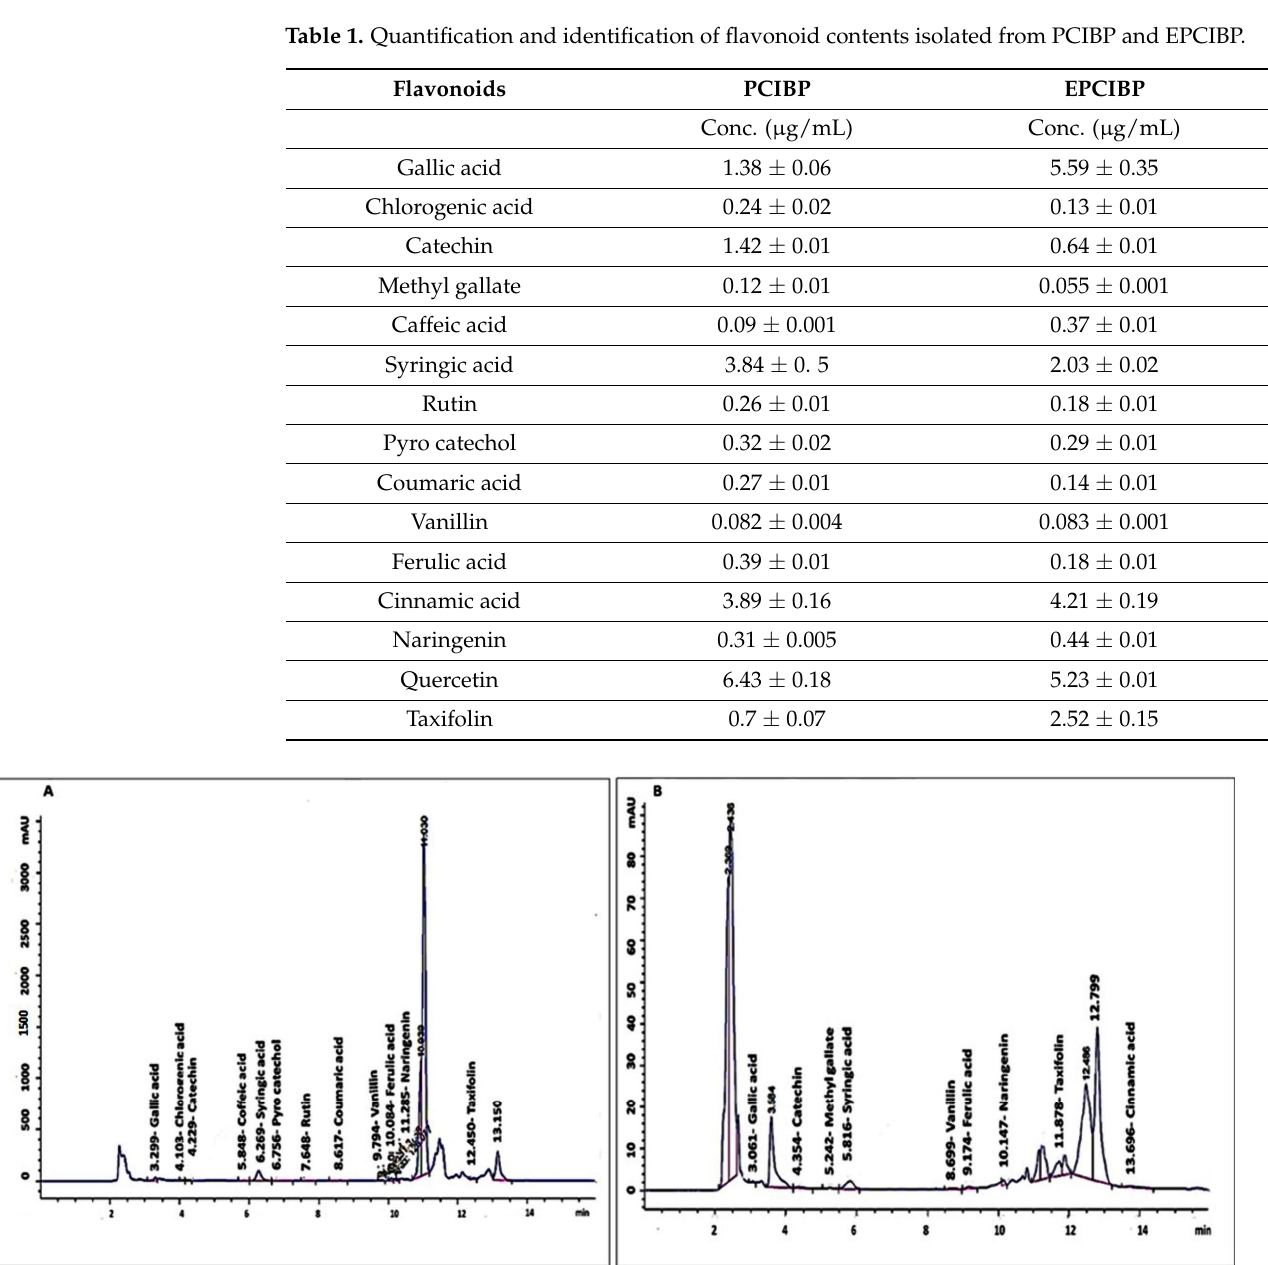
Table 1. Quantification and identification of flavonoid contents isolated from PCIBP and EPCIBP.